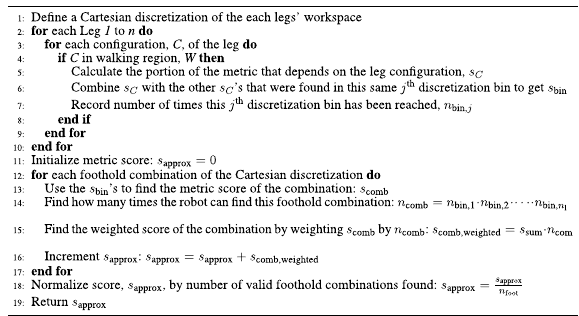
Algorithm 1. General Legged Robot Metric Over Con fi guration Space